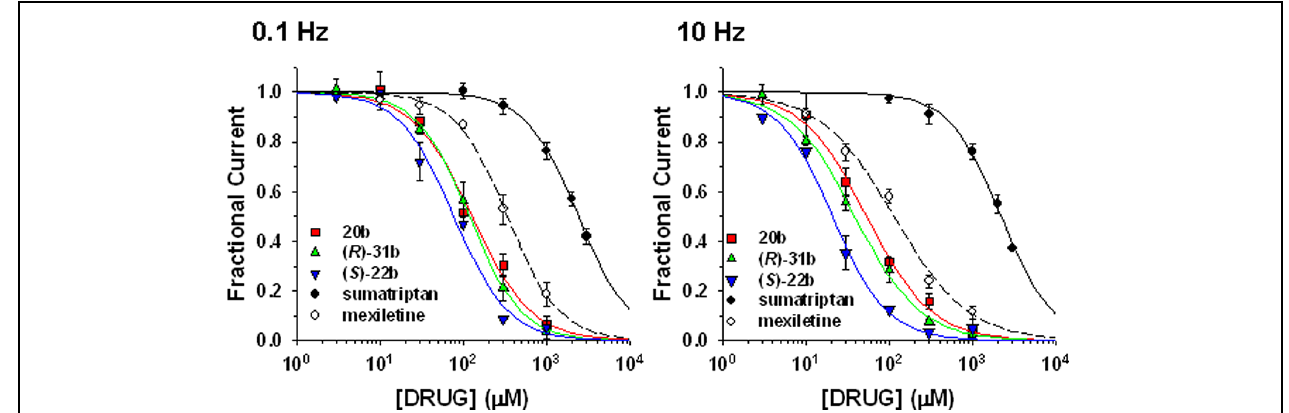
FIGURE 3 | Concentration–response relationships for mexiletine, sumatriptan, and its three analogs on hNav1.7 channels. The curves were constructed at 0.1 and 10 Hz frequency stimulations from peak amplitude values of sodium currents recorded as described in Figure 2 ,